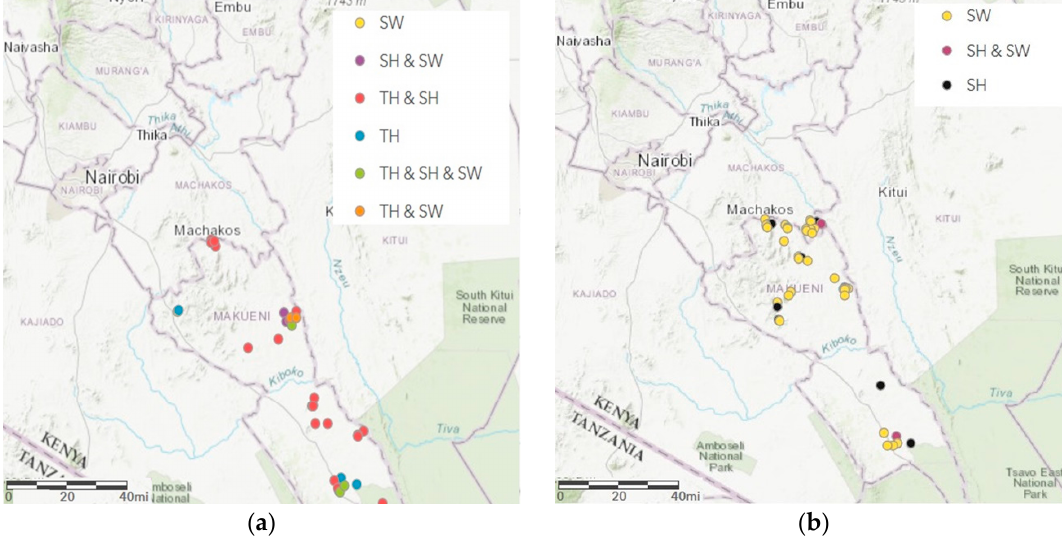
Figure 2. The maps showing the sample sites in ( a ) field study 1 and ( b ) field study 2. SW: shallow well, SH: scoop hole, TH: test hole.